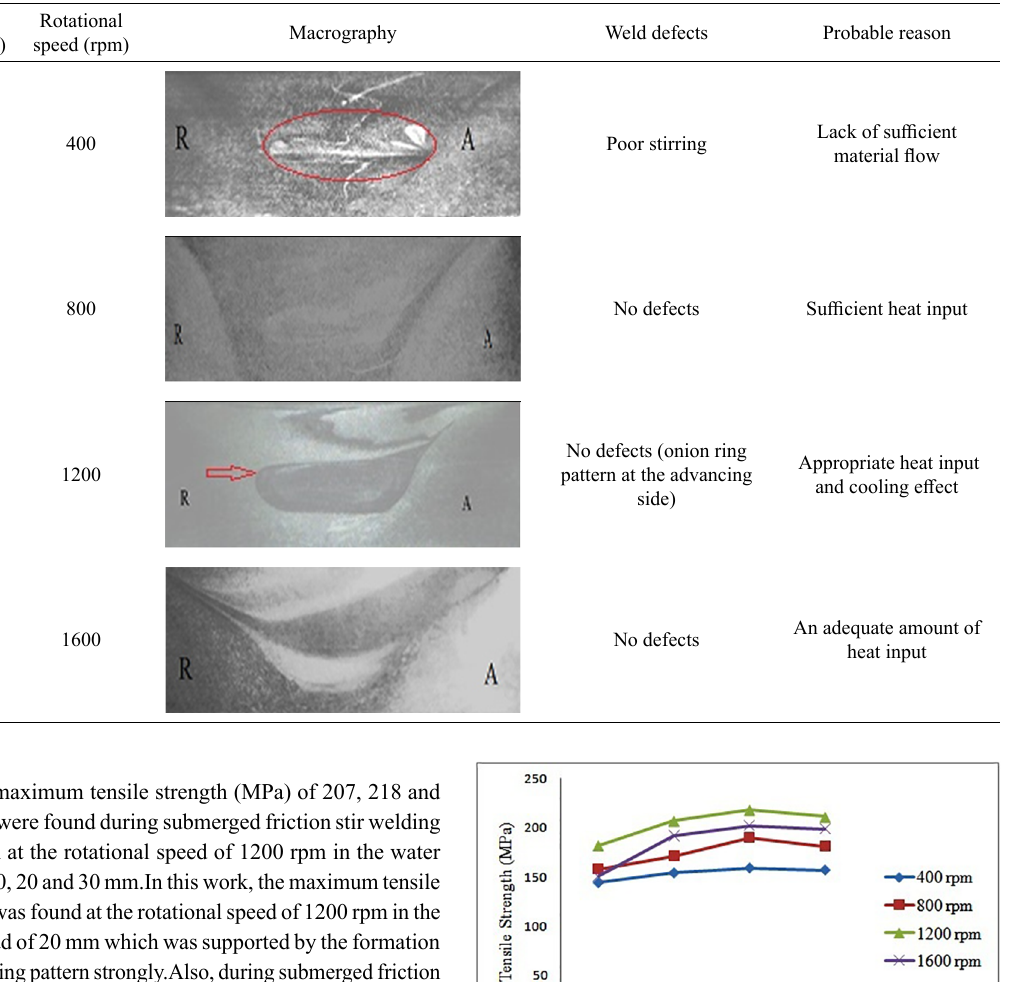
Figure 9 . Tensile properties of FSW and SFSW (SFSWa friction stir welding for 10 mm water head;SFSWb- Submerged friction stir welding for 20 mm water head;SFSWc - Submerged friction stir welding for 30 mm water head; FSW - Friction stir welding for without water